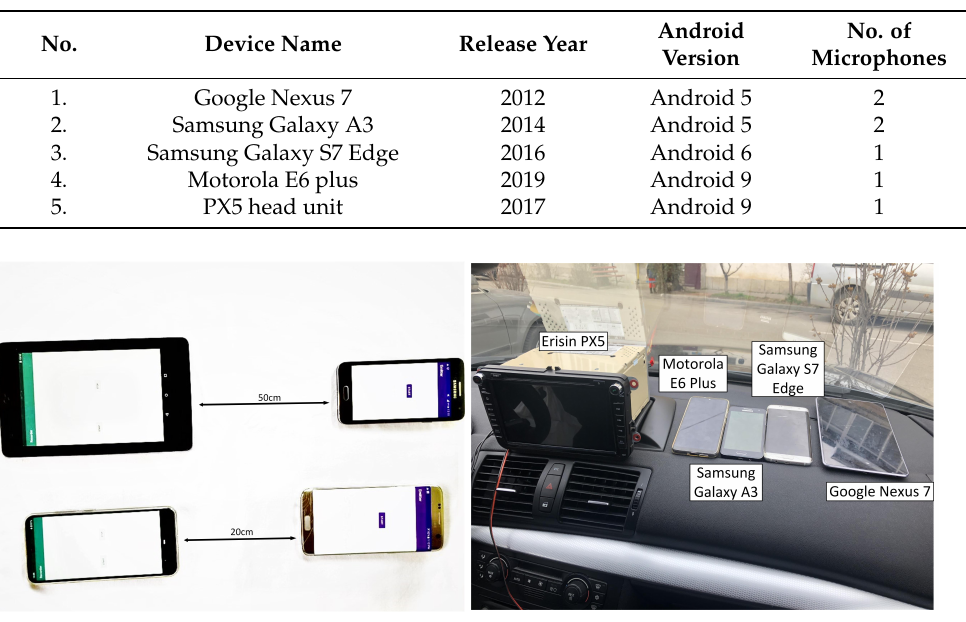
Figure 2. The four phones used in our experiments in-doors ( left ) and on the vehicle dashboard with the head unit ( right